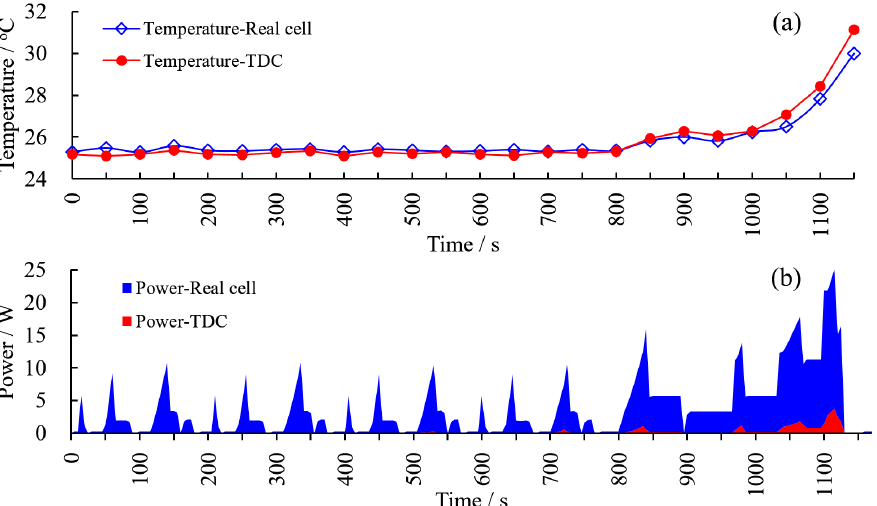
Figure 12. Temperature and power of the TDC compared with the real cell under New European Driving Cycle (NEDC) condition: ( a ) surface temperature at the midpoint under NEDC condition; ( b ) electrical power consumed by the TDC and a real cell in the experiment.